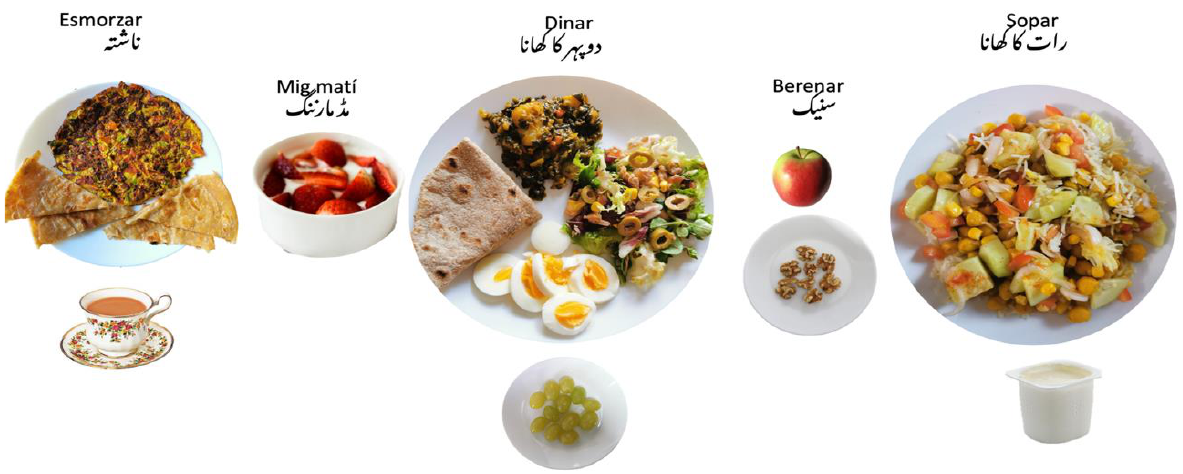
Figure 7. Example of a qualitative one-day